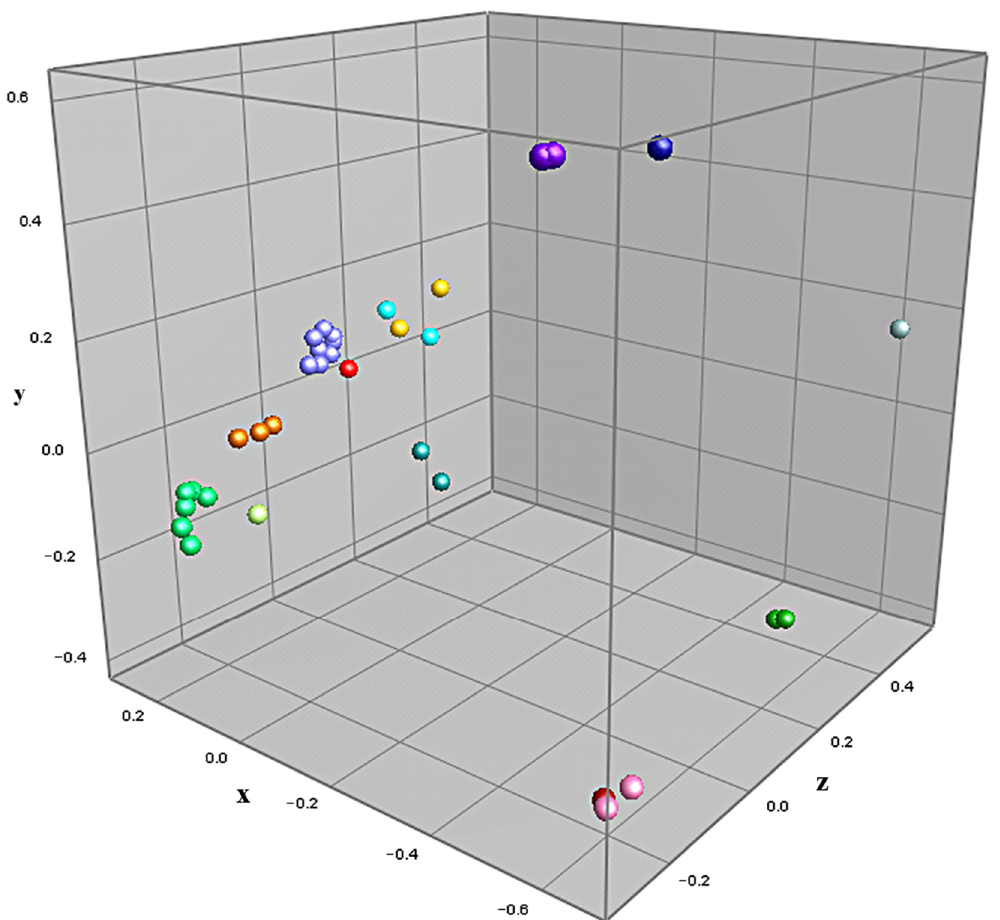
Figure 2. MDS scatterplot, with optimized positioning, based on cluster analysis described in Figure 1. Data points are color-coded based on presumptive strain groups.